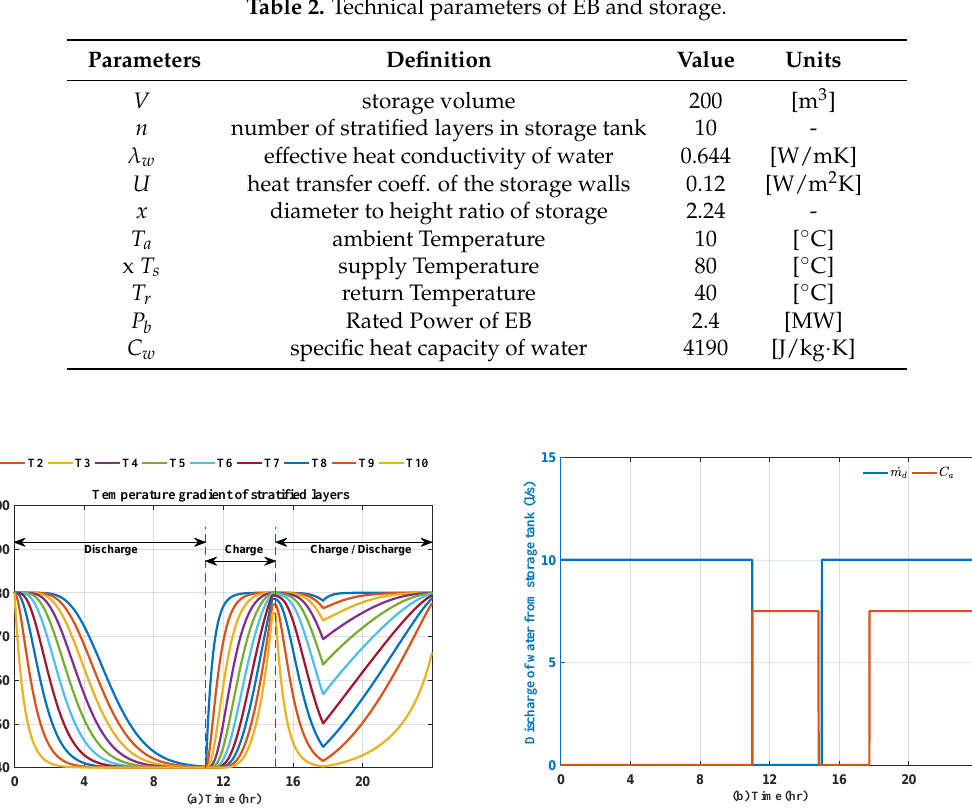
Figure 11. Temperature gradient of stratified layers ( a ) during discharge, charge, and charge-discharge of storage tank ( b ) discharge of water from the storage tank and status of the heater